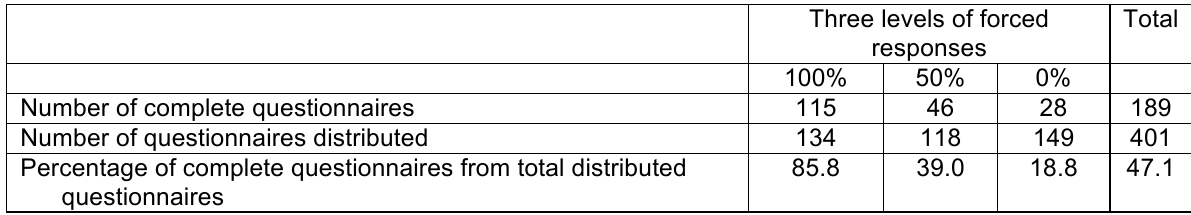
Table 2: Survey responses categorized by three levels of forced